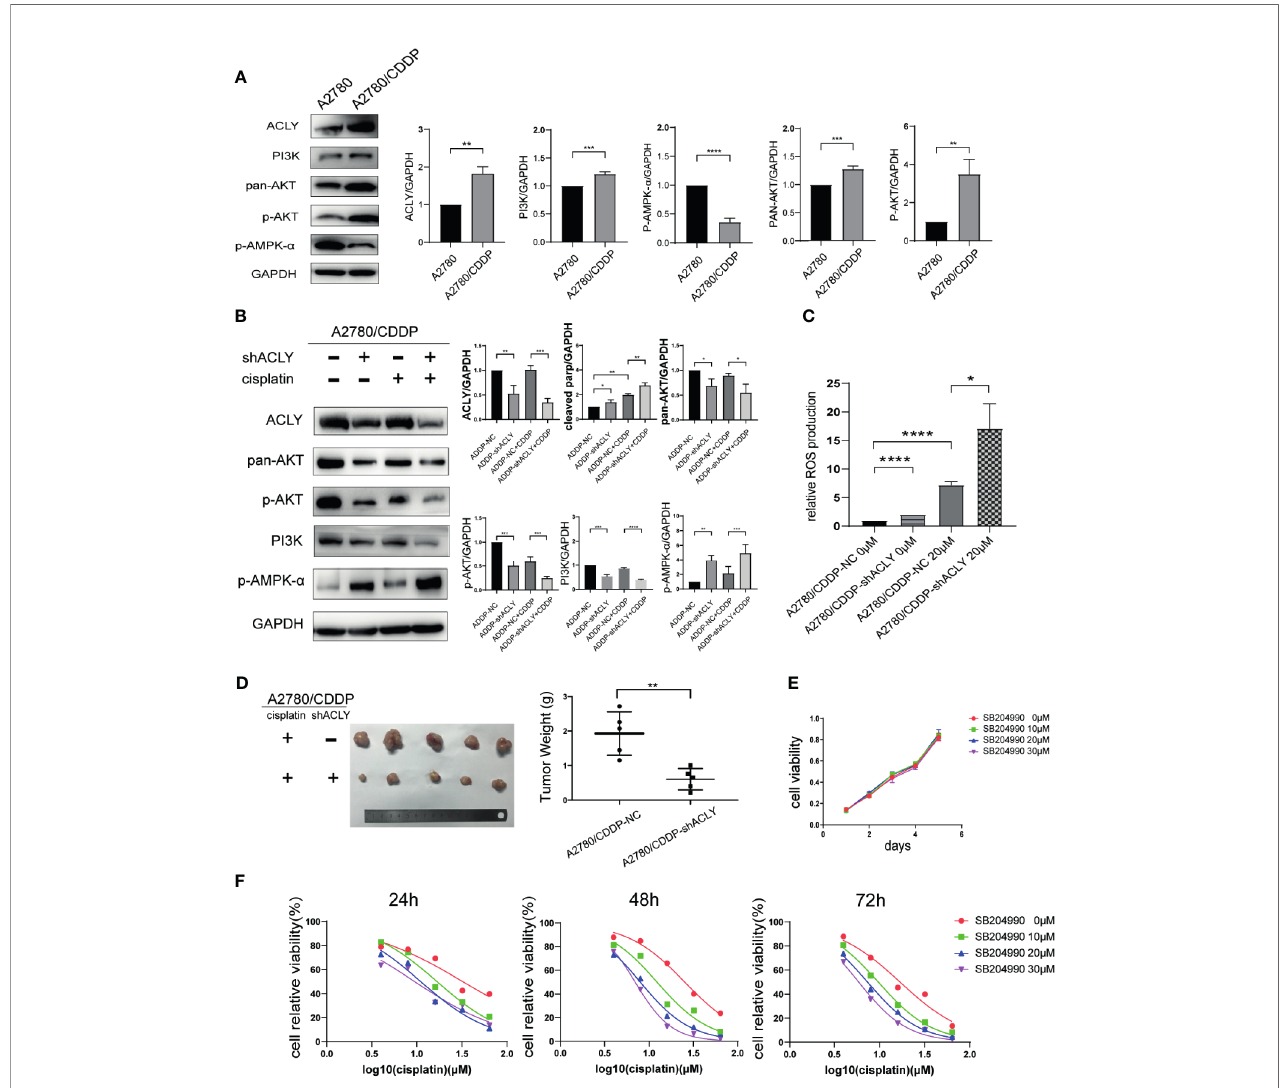
FIGURE 5 | ACLY knockdown inhibited PI3K/AKT pathway and activated AMPK pathway. (A) Western blotting was used to detect the differential expression of ACLY, PI3K/AKT pathway and p-AMPK-a in A2780 and A2780/CDDP cells. (B) Western blotting on A2780/CDDP-NC and A2780/CDDP-shACLY cells, and them under 20 m M cisplatin treatment for 48 h, the bands were quanti fi ed and analyzed. The bands were quantitated with Image J software, statistical analysis was performed using Student ’ s t-test. (C) ROS production of the aforementioned cells and them under treatment of 20 m M cisplatin for 48 h, statistical analysis was performed using Student ’ s t-test. (D) Tumor xenograft formation of A2780/CDDP-NC and A2780/CDDP-shACLY cells with treatment of cisplatin, with each group containing fi ve mice. The difference in tumor weights was compared using Student ’ s t-test. (E) Proliferation of A2780/CDDP cells in respond to different concentration (low-dose, 10 – 30 m M) of SB-204990, the growth curves were analyzed using one-way ANOVA test. (F) 24, 48, and 72 h IC50 of A2780/CDDP cells under treatment of cisplatin combined with different concentration of SB-204990 (from 0 to 30 m M), 24 h IC50 of which were 32.34 (26.71 – 40.60), 16.75 (15.24 – 18.43), 11.08 (9.736 – 12.55), 9.495 (7.759 – 11.38) m M, respectively; 48 h IC50 of which were 25.37 (23.86 – 27.00), 12.33 (10.74 – 14.13), 7.983 (7.487 – 8.499), 6.979 (6.749 – 7.215) m M; 72 h IC50 of which were 16.96 (14.89 – 19.34), 9.727 (9.294 – 10.18), 7.407 (7.083 – 7.741), 5.922 (5.601 – 6.246) m M, respectively. All cell experiments were repeated three times at least. * P < 0.05, ** P < 0.01, *** P < 0.001, and **** P < 0.0001 for statistical analysis of the indicated